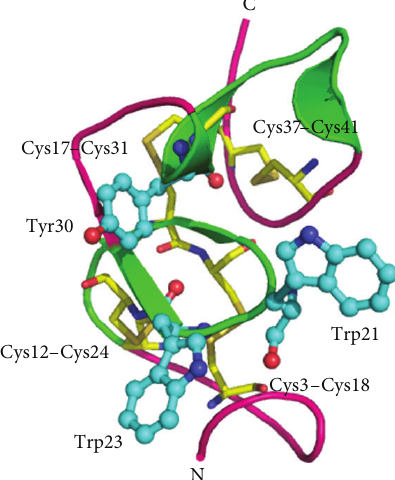
Figure 7: Overall structure of Hev b 6.02 (hevein) showing IgE binding epitopes (in green). Trp21, Trp23, and Tyr30 form an aromatic patch in the conformational epitope. The four disulphide linkages are shown in yellow.